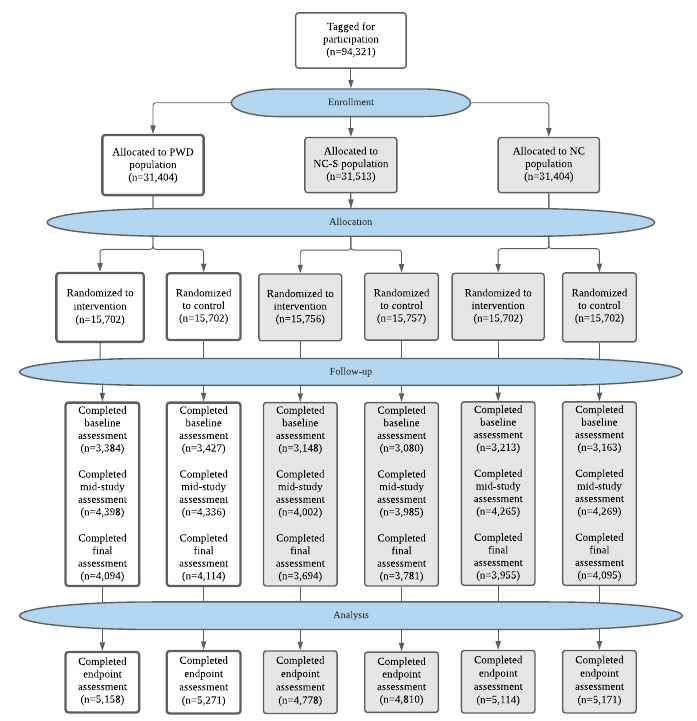
Fig. 1 CONSORT fl ow diagram. CONSORT diagram presents the study fl ow for the larger investigation (NCT03870997). PWD people with diabetes, NC-S normal controls-similar, NC normal controls.